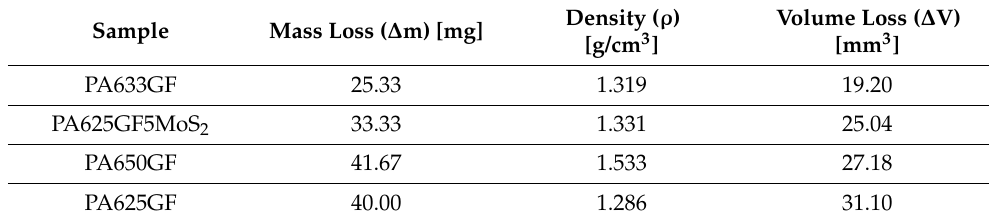
Table 5. Wear amount and densities of composite samples.